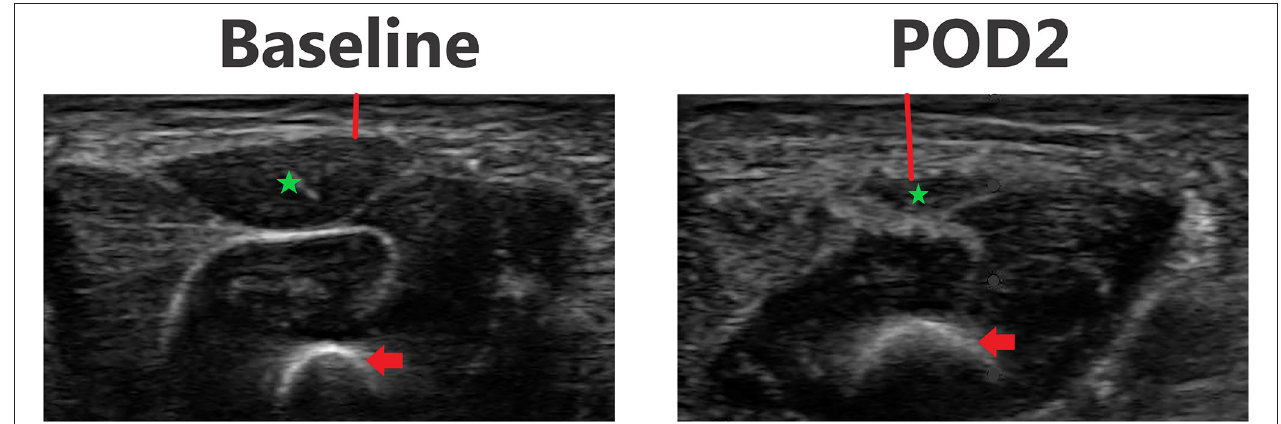
FIGURE 6 | Point-of-care ultrasound images of anterior thigh at baseline and POD 2 of the same patient. Both images are presented on identical scales (total depth of 1.8cm from the skin). Red vertical line demonstrates subcutaneous tissue thickness—there is a marked increase in subcutaneous tissue seen on POD 2. Red arrow—femur bone. Green star—echogenic muscle changes seen on POD 2.